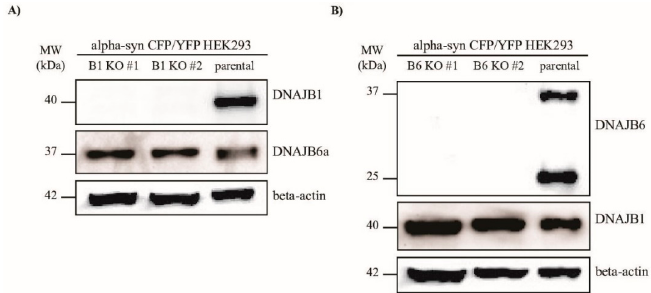
Figure 1. Western blot analysis of the CRISPR-Cas9-mediated knockout (KO) of DNAJB1 and DNAJB6 in the alpha-synuclein ( α -Syn) CFP/YFP HEK293 cells. Western blots displaying the expression of ( A ) DNAJB1 or ( B ) DNAJB6 in the cell lines knocked out for these two genes, respectively, or parental control α -Syn CFP/YFP HEK293 cells. In order to induce α -Syn aggregation in these KO clones, 10 nM of pre-formed fibrils (PFFs) of α -Syn were added to the cells for 48 h. The aggregation of α -Syn was first assessed by IF microscopy, and was determined by counting the percentage of cells showing a combination of CFP- and YFP- positive aggregates. The DNAJB6 KO cells showed a two-fold increase in the α -Syn aggregation compared with the parental cells for both the individual DNAJB6 KO clones, whereas none of the DNAJB1 KO clones displayed any significant change in the α -Syn aggregation compared with the parental cells (Figure 2A). On average, for the independent clones, DNAJB6 KO resulted in a strong, significant increase in α -Syn aggregation (Figure 2B,C). Staining for the expression of endogenous DNAJB1 and DNAJB6 revealed that both are, to a large extend, found in the cytoplasm, and therefore colocalize in the same compartment as α -Syn (Supplementary Figures S1 and S2).